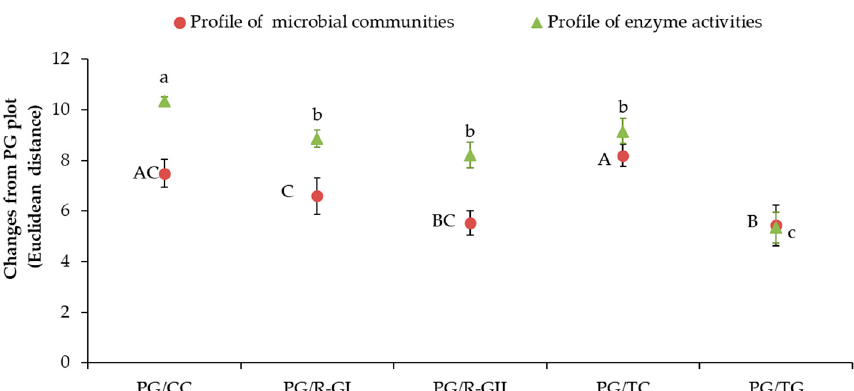
Figure 4. Changes on the levels of the abundance of microbial communities and enzymes activities expressed by Euclidean distance using the PG soil state as a reference state. Different letters indicate a significant difference between plots using Kruskal–Wallis test ( p < 0.05, n = 4). Upper letters indicate a significant difference in the abundance profile, and lowercase letters indicate a significant difference in enzyme profile.